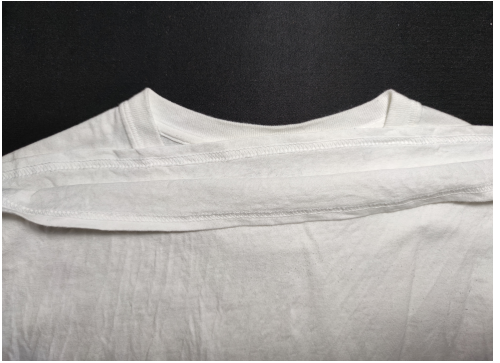
Figure 7. The cotton t-shirt used in non-contact sensing